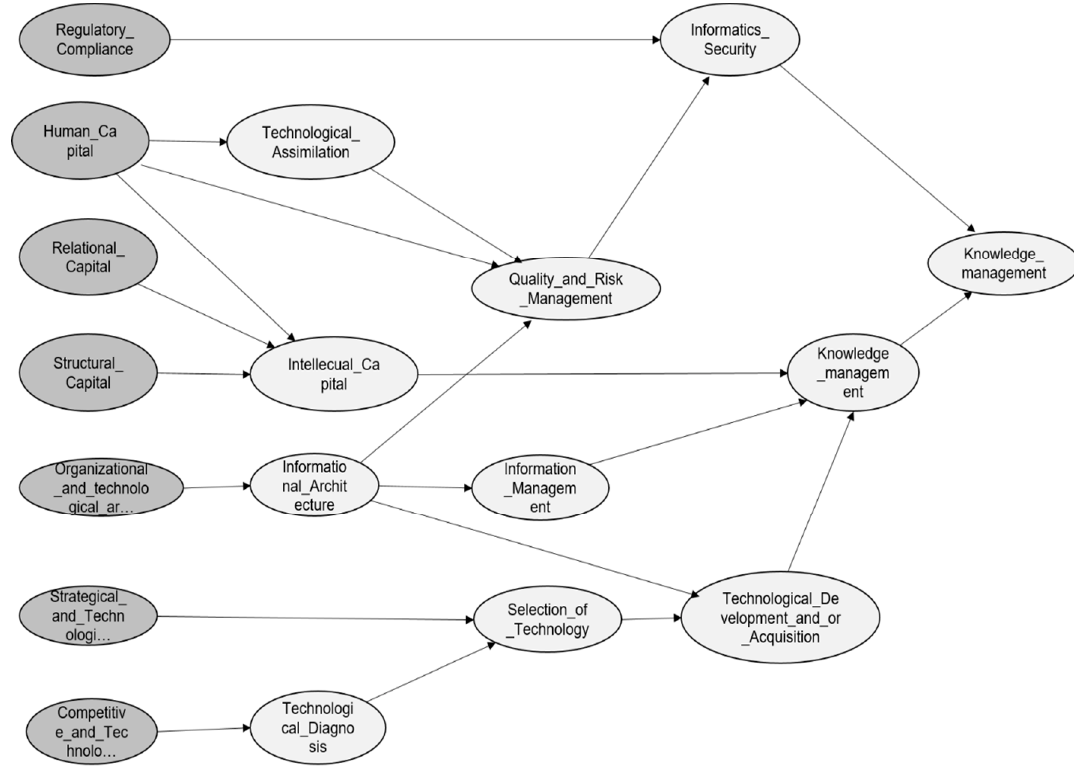
Figure 1. Scheme of the knowledge management model: variables and nodes. Table 2. Definition of the variables and